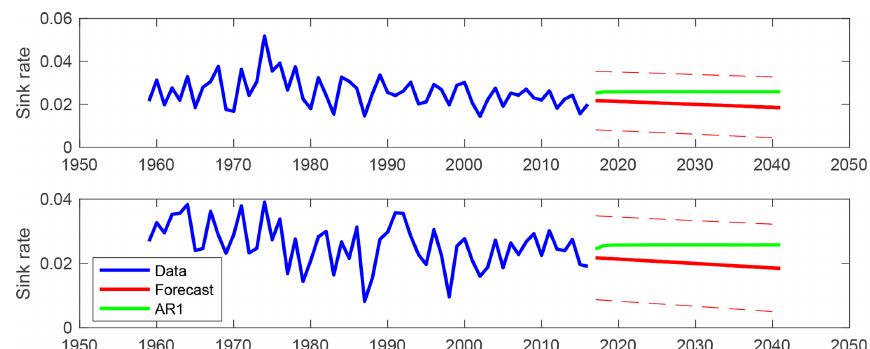
Figure 3. The blue solid line represents the data, while the red solid line represents the point forecasts from the Kalman filter with the unknown parameters estimated by maximum likelihood. The dashed red lines are 95% confidence bands ( ± 1 . 96 standard deviation) for the forecasts. The green line represents the forecasts from an autoregressive model of order